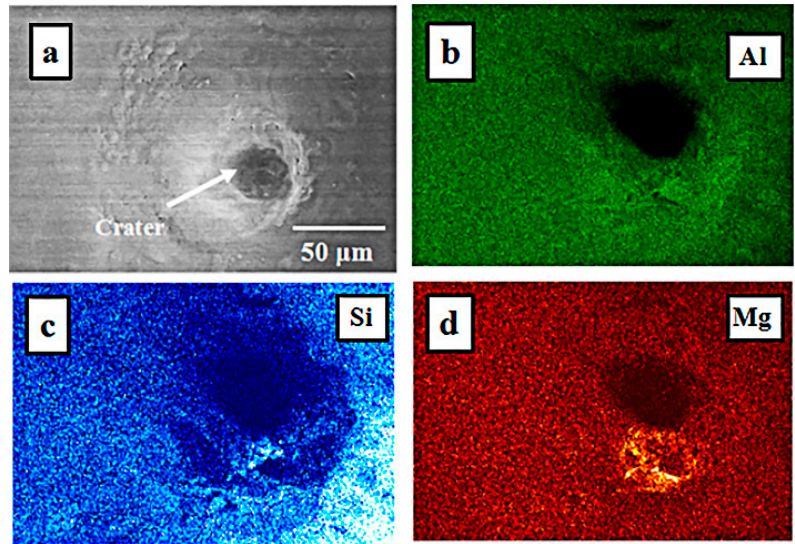
Figure 2. Element distribution maps of Al–20Si–5Mg alloy surface after HCPEB treatment with 25 pulses: ( a ) BSE (Back scattered electron) image; ( b ) element distribution of Al; ( c ) element distribution of Si; and ( d ) element distribution of Mg.